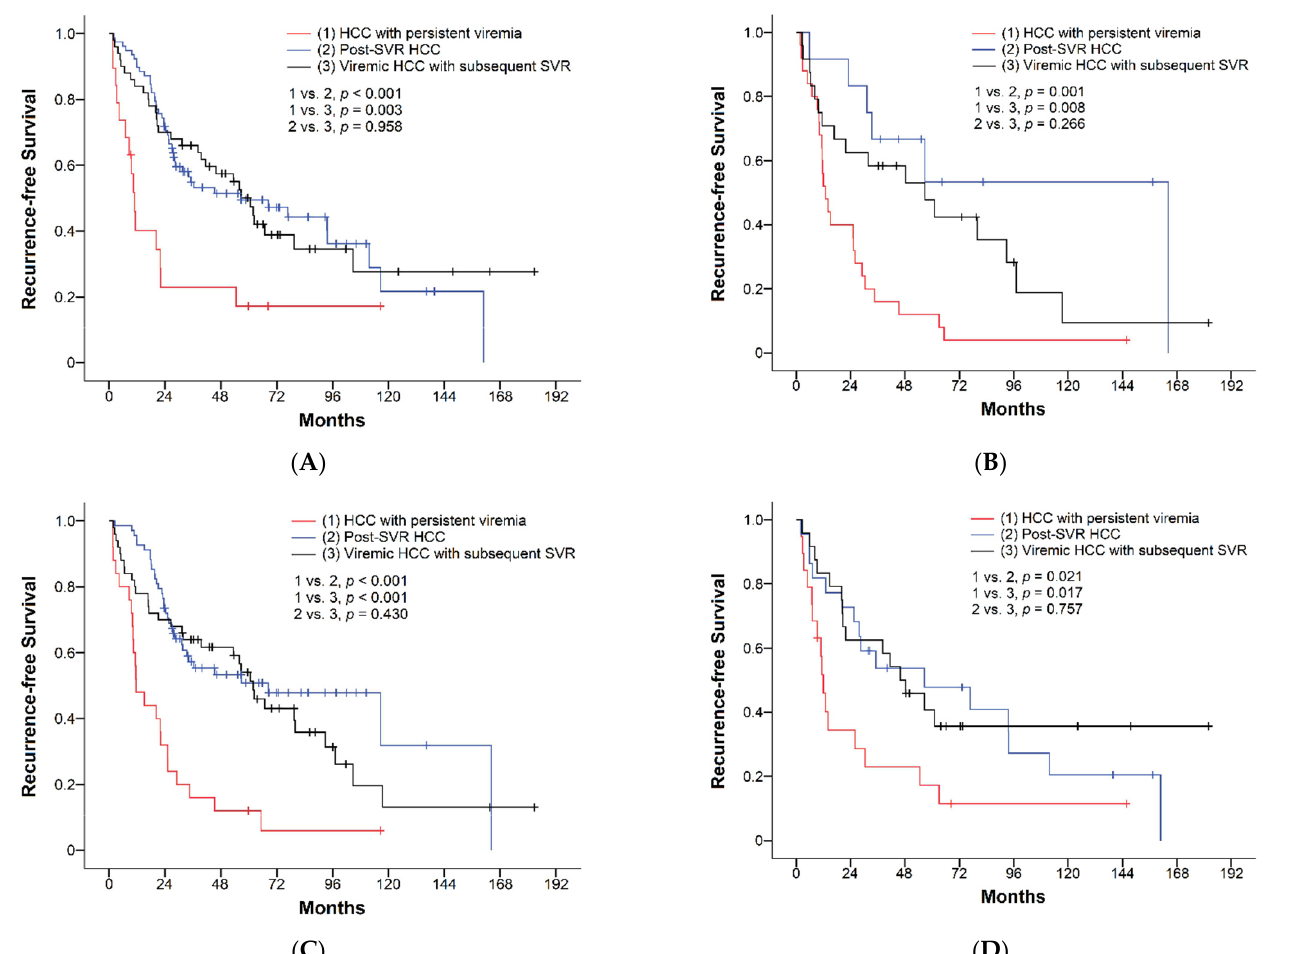
Figure 4. Comparisons of recurrence-free survival of HCC based on viral status in patients with ( A ) ALBI grade I, ( B ) ALBI grade II/III, ( C ) non-LC, and ( D ) LC.